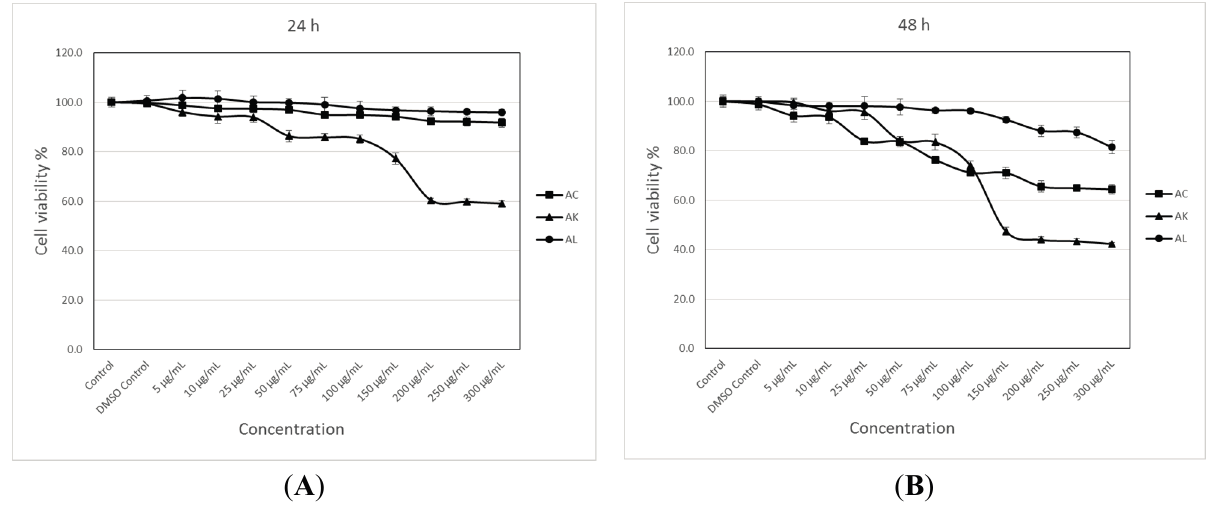
Figure 9. Cytotoxic effects of AC, AK and AL on MCF-7 cells estimated by the MTT reduction assay. Cells were treated with nothing (control, only medium), vehicle (DMSO, 0.1% in medium), and different concentrations of the extracts for 24 h ( A ); and 48 h ( B ). Data are mean ± SEM values ( n =